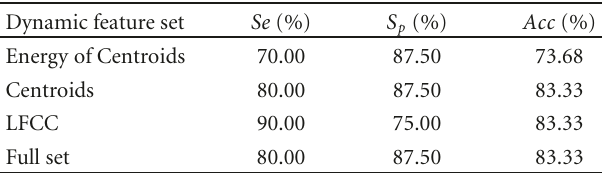
Table 4: Classification of patient for training based on partially divided set of dynamic